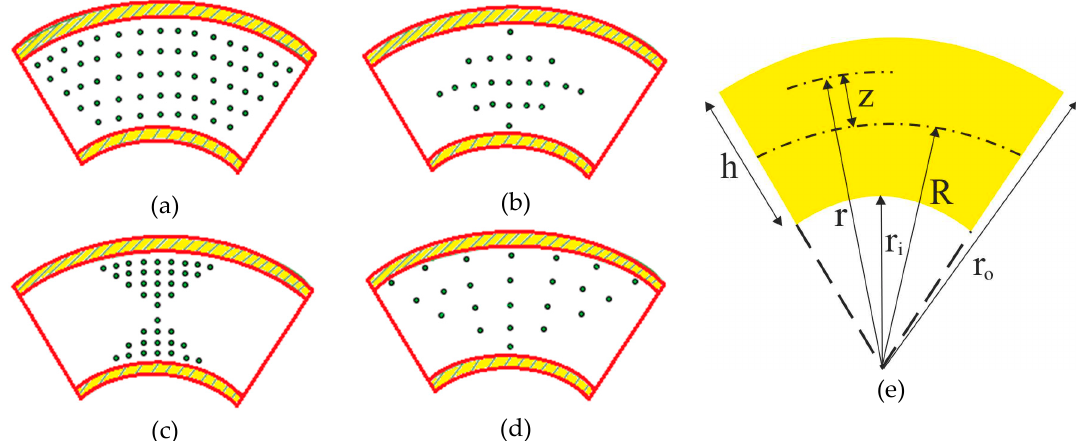
Figure 1. Geometry of the carbon nanotube-reinforced composite (CNTRC) cylindrical shell, with different CNTs distribution patterns: (a) UD, (b) FG-O, (c) FG-X, (d) FG-V, (e) Geometry.